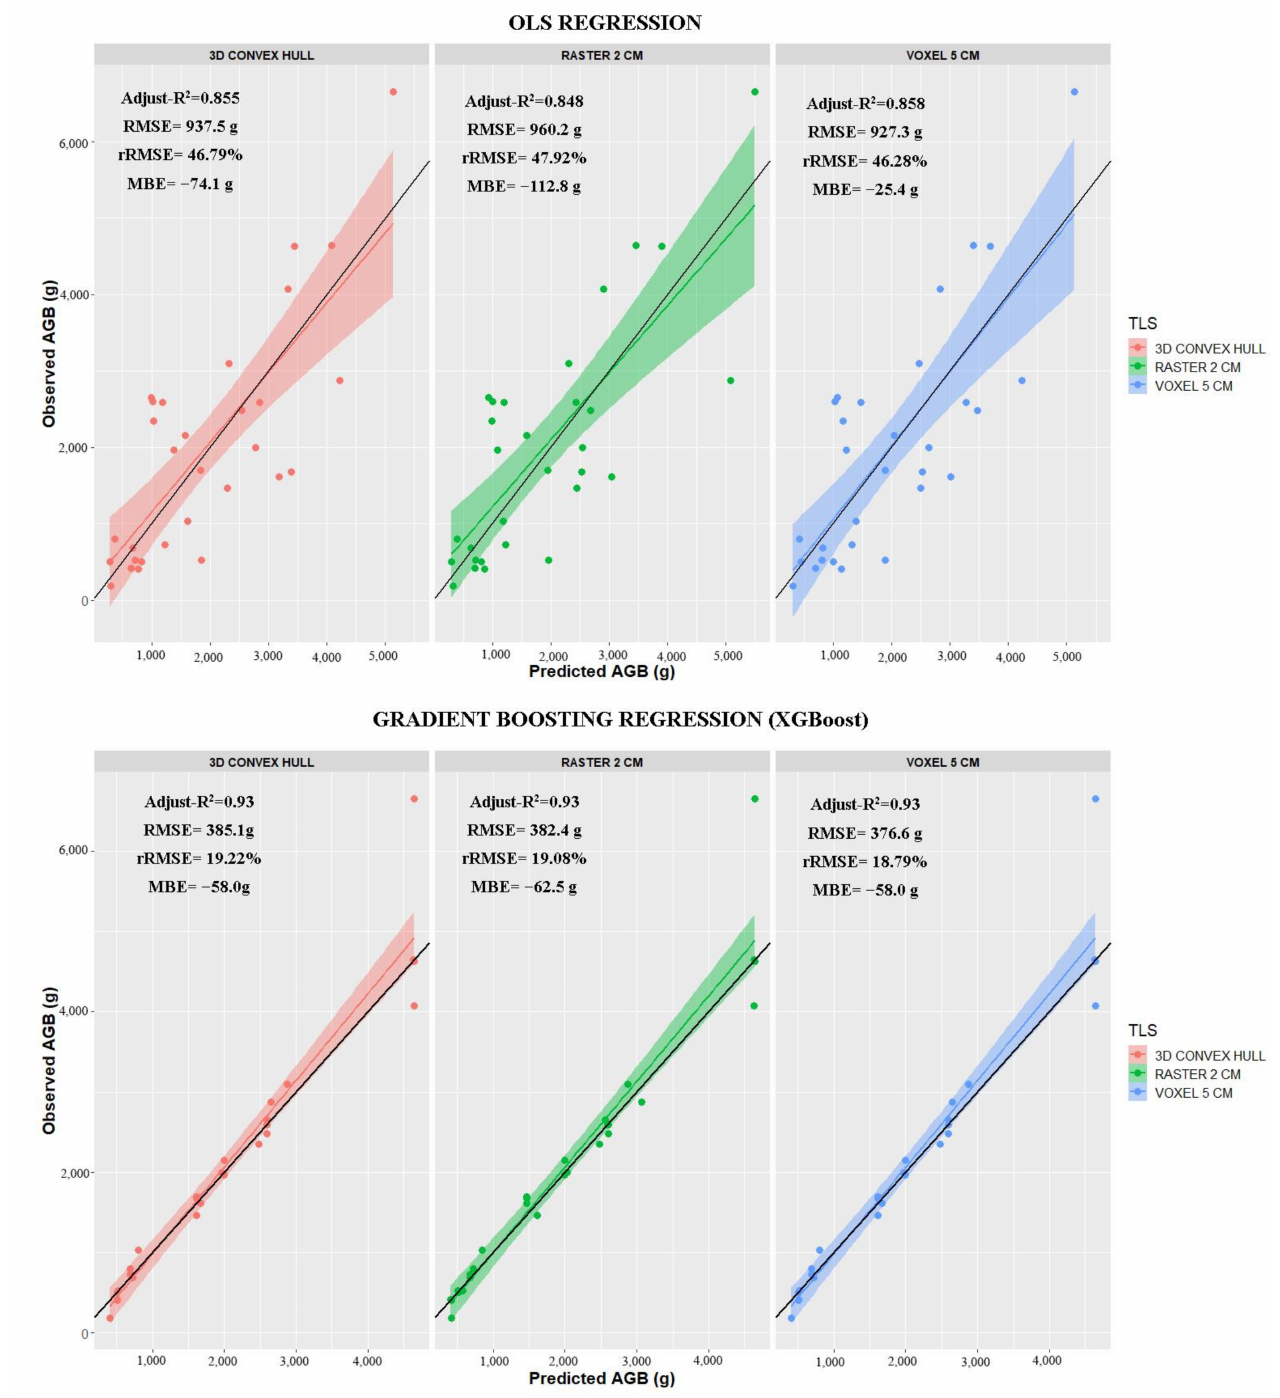
Figure 3. Relationships between observed and predicted AGB (g) according to the best spatial resolution for voxel (5 cm) and raster (2 cm). XGBoost represents the results according to the best set of tunning parameters described in Supplementary Figure S1. Black line represents 1:1